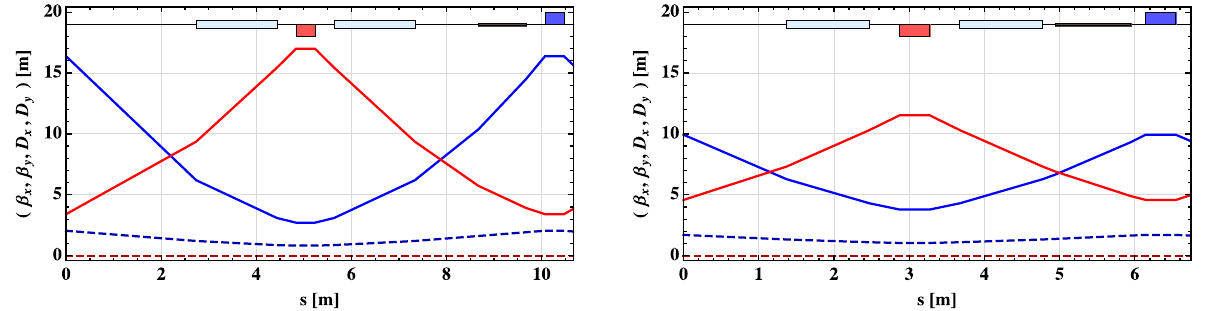
FIG. 10. Optics of one FODO cell for a regular FODO lattice consisting of 15 (left) and 24 (right) cells and a working point of =Q ¼ 4 . 28 = 3 . 55 . Q x y